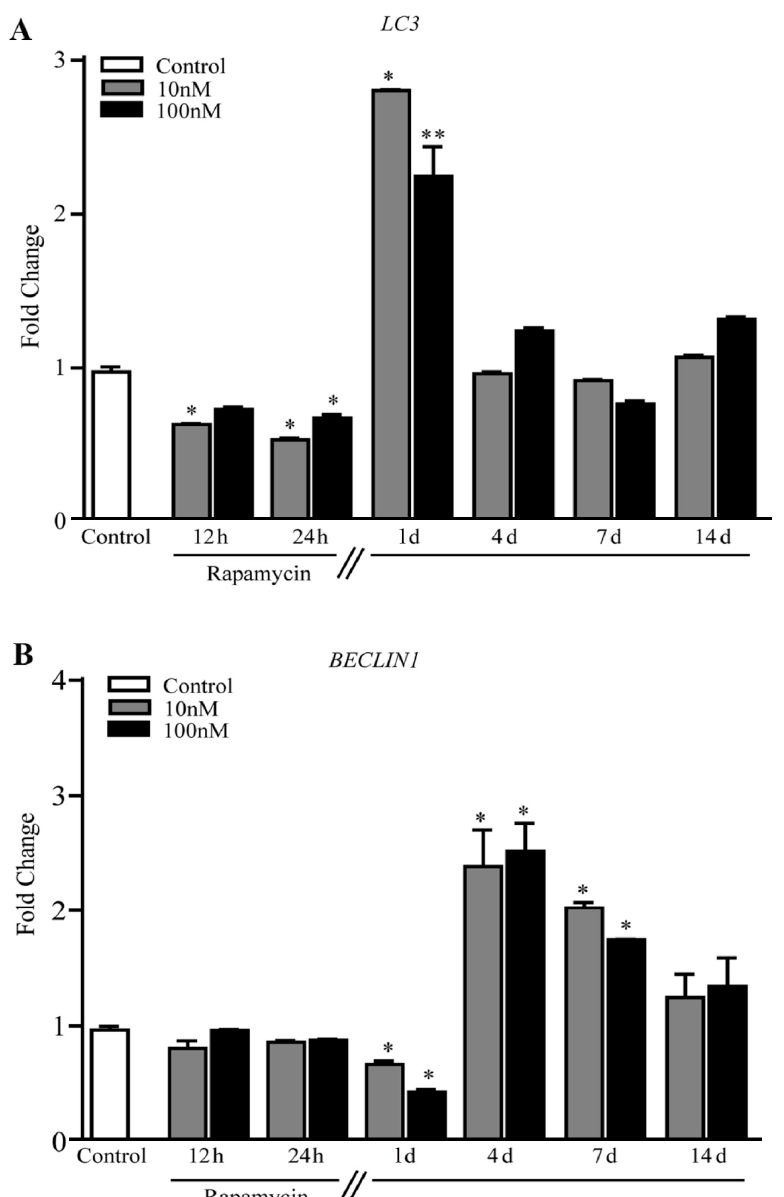
Figure 13. Rapamycin increases the expression of autophagy related genes in U87MG cells. ( A ) RT- PCR for LC3 , and ( B ) RT-PCR for BECLIN1. * p ≤ 0.05 vs Control. ** p ≤ 0.05 vs Control and 10